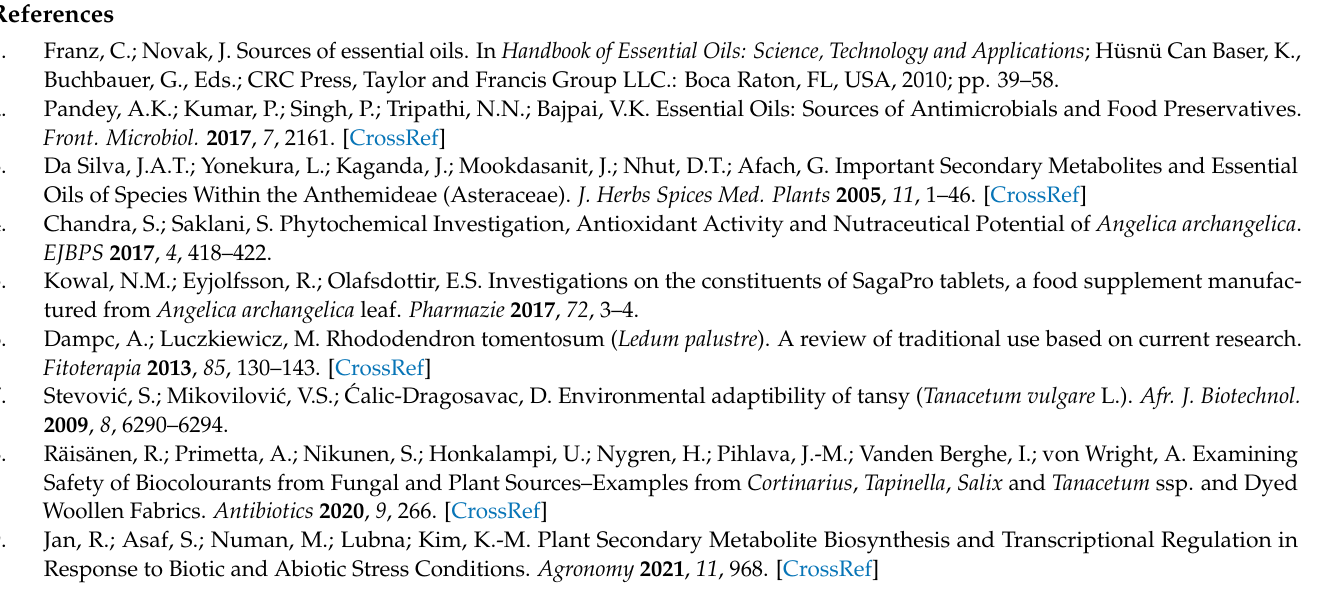
Figure S39: fragmentation pattern of n-nonacosane found in silylated marsh Labrador tea scCO 2 extracts and common tansy inflorescence scCO 2 extracts, Figure S40: fragmentation pattern of hen- triacontane found in silylated marsh Labrador tea scCO 2 extracts and common tansy inflorescence scCO 2 extracts, Figure S41: fragmentation pattern of lupeol, TMS derivative found in silylated marsh Labrador tea scCO 2 extracts, Figure S42: fragmentation pattern of linoleic acid, TMS derivative found in silylated Angelica root scCO 2 extract and common tansy inflorescence scCO 2 extracts, Figure S43: fragmentation pattern of parthenolide, TMS derivative found in silylated common tansy inflorescence scCO 2 extracts, Figure S44: fragmentation pattern of β -amyrin, TMS derivative found in silylated marsh Labrador tea scCO 2 extracts and common tansy inflorescence scCO 2